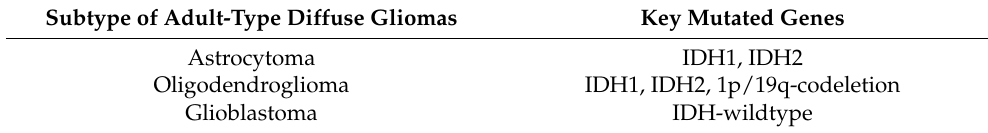
Table 1. Classification and key genetic mutations of the adult-type diffuse gliomas